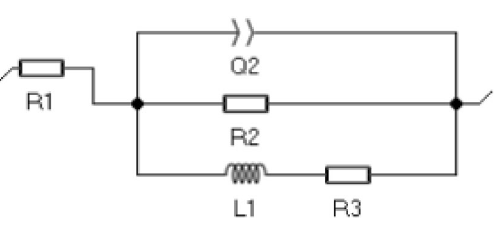
Figure 16. An equivalent circuit that represents the impedance